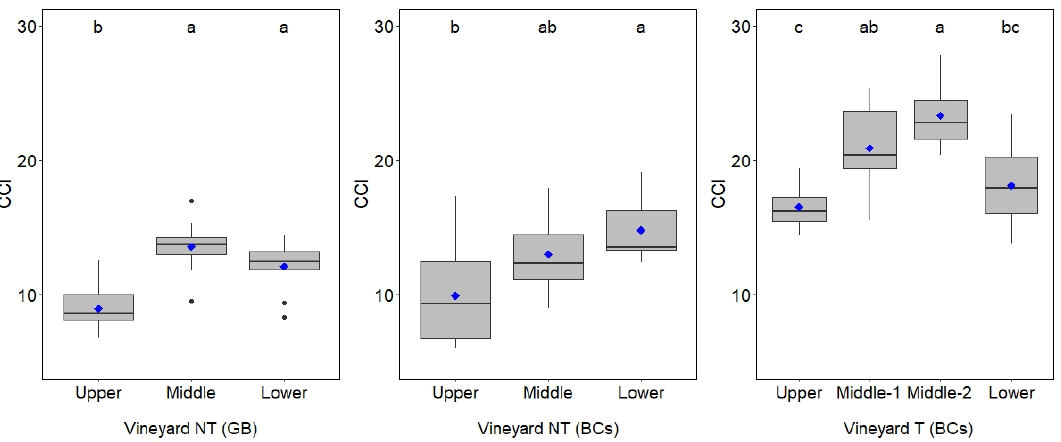
Figure 5. Boxplot of the chlorophyll content index (CCI) averages of the BCs and GB grapevine leaves for the upper, the middle, and the lower slope points. Data showing yearly median (solid black line), mean (blue diamond), upper and lower quartiles, and minimum and maximum values (whiskers; data plus/minus 1.5 interquartile range). Different letters indicate statistically significant differences at p < 0.05.